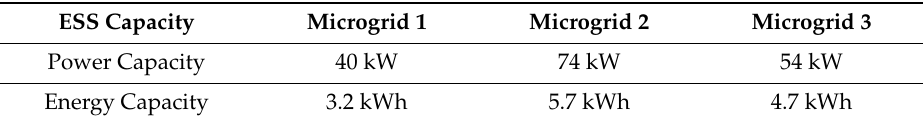
Table 3. ESS capacity of interconnected microgrid scheme with Objective